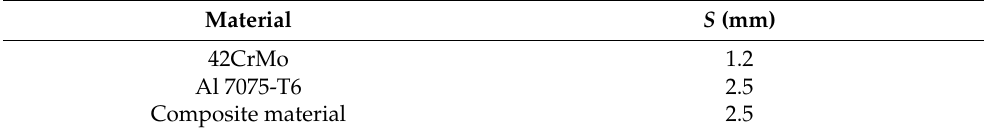
Table 11. Calculated cylinder thickness.